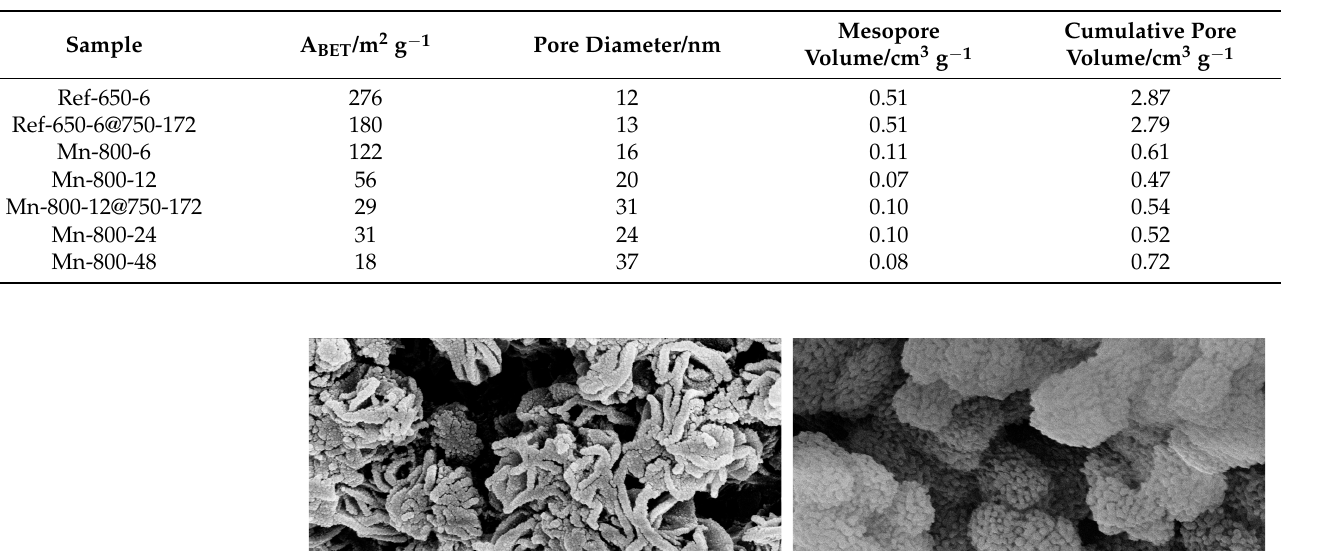
Table 2. Cumulative pore volume, mesopore volume and mesopore diameter obtained by mercury intrusion and specific surface area (A BET ) obtained by nitrogen sorption.